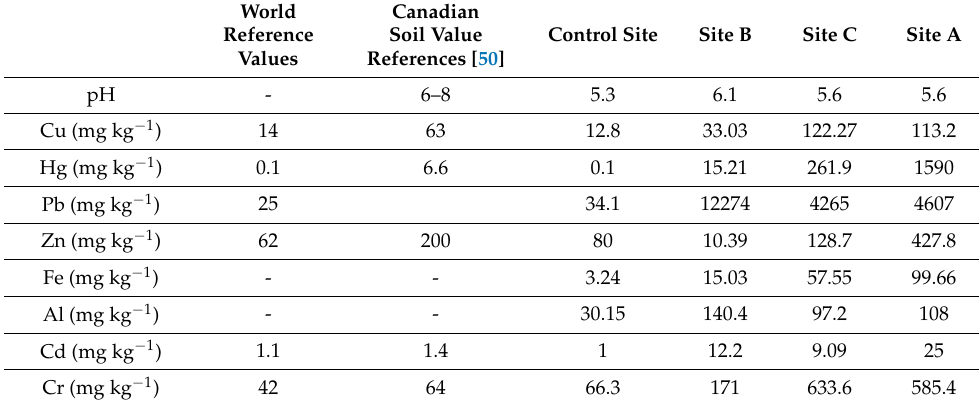
Table 1. Trace element concentrations in soil. World reference values by [49] and Canadian soil value references